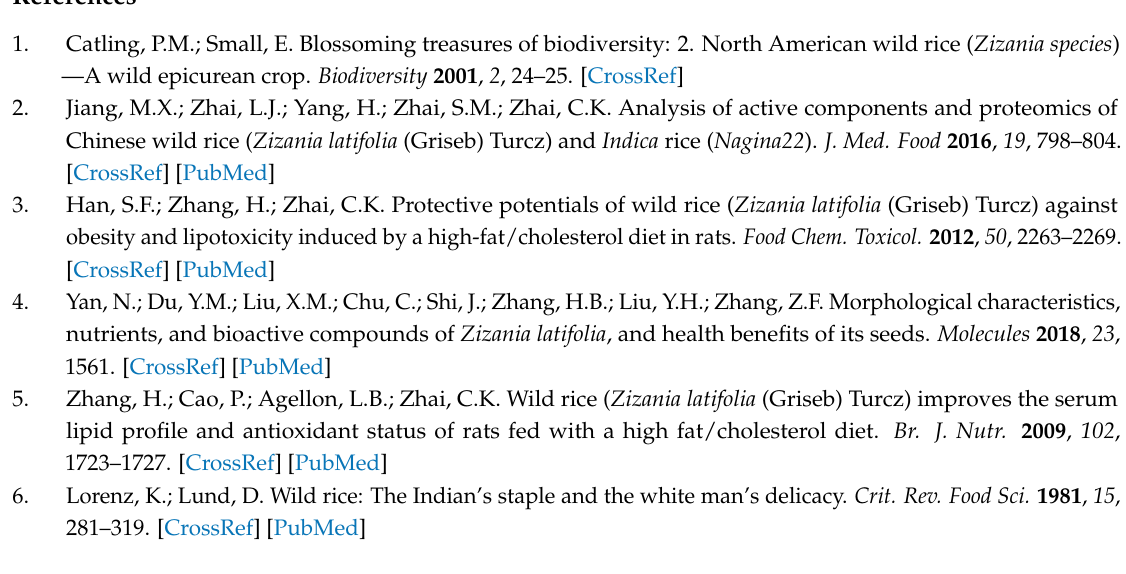
Supplementary Materials: Supplementary materials are available online. Table S1: Phenolic acids and flavonoids found in wild rice in previous reports; Table S2: Physical properties of six macroporous resins; Table S3: The ion transitions, optimized MS parameters, and linear relationships of the standards in UPLC-QqQ-MS/MS analysis; Figure S1: The radical scavenging activities of DPPH (A) and ABTS (B), reducing power (C), total flavonoid content (TFC) (D), and total phenolic content (TPC) (E) of different solvent extracts of wild rice collected from Jingzhou; Figure S2: Dynamic breakthrough curve of antioxidants on D101 resin column; Figure S3: Structures of phenolic compounds identified in wild rice; Figure S4: Base peak chromatograms of Frs. 1 (A) and 2 (B) in HPLC-LTQ-Orbitrap-MS n analysis; Figure S5: HPLC fingerprint chromatograms at 360 nm (A) and 280 nm (B) of the four fractions (Frs. 1–4) eluted from D101 resin column. The gradient solvent system consisting of A (methanol) and B (water containing 0.1% acetic acid, v / v ) was as follows: 0–10 min, 5–10% A; 10–30 min, 10–15% A; 30–40 min, 15–20% A; 40–50 min, 20–25% A; 50–60 min, 25–35% A; 60–70 min, 35–90% A; 70–80 min, 90–60%